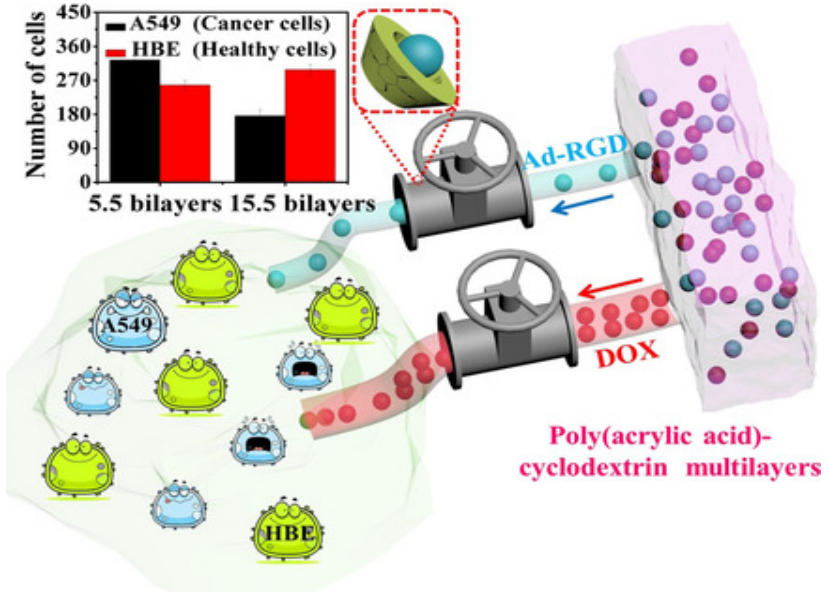
Figure 9. Representation of the selective flux regulation in LbL films by supramolecular interactions between cyclodextrin and its guests. Inset: difference in cell viabilities between human healthy cells (HBE) and cancer cells (A549). Taken from [71], with permission from John Wiley Sons, Inc.